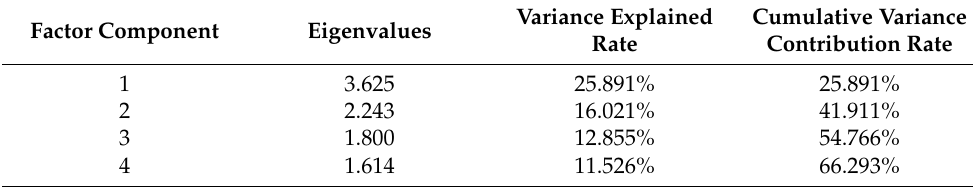
Table 4. Variance interpretation results.